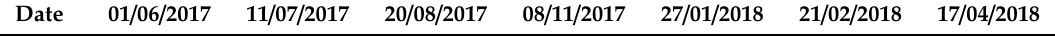
Table 2. Dates of cloud free S2 acquisitions over Doñana, coinciding with Landsat ones, with the exception of one date. Landsat acquisition was one day earlier than the S2 acquisition on 21 February,